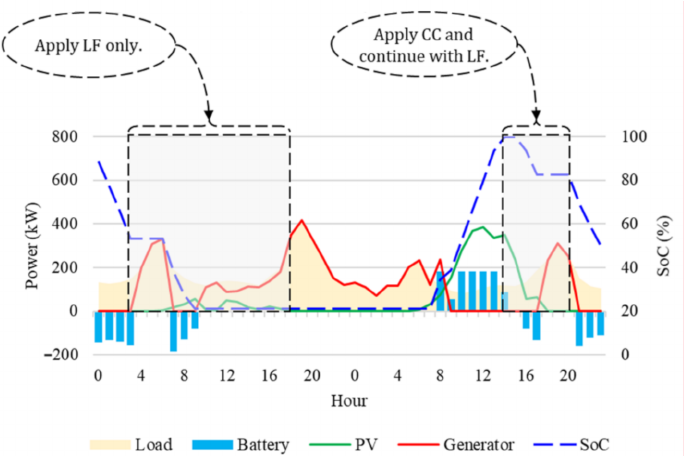
Figure 7. Analysis of CD control strategy implementation was captured on 1 and 2 January. It works as an LF control strategy in the low load period and as a CC control strategy in the high load